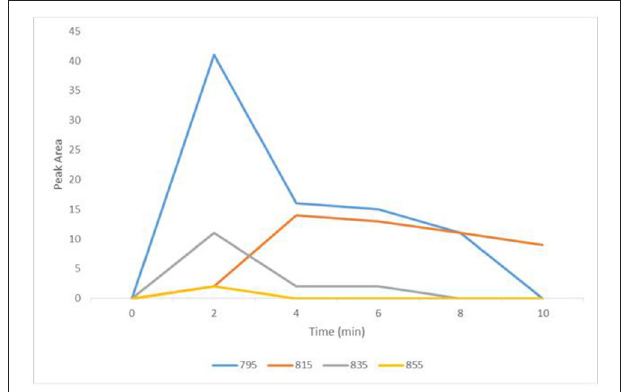
FIGURE 4 | Degradation intermediates of MC-LR during microbubble treatment at a flow rate of 1L min − 1 equivalent to 0.199 ppm O 3 . Peak A, 795 (blue); Peak B, 815 (orange); Peak C, 835 (gray); Peak D, 855